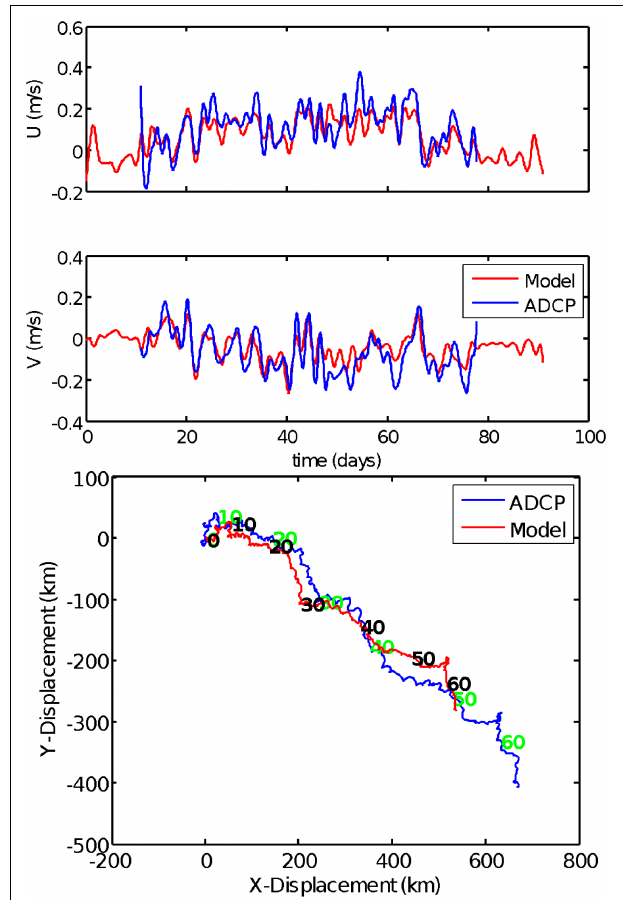
FIGURE 5 | Top panel: Comparison between U and V observed using ship-based ADCP (blue) and predicted using the GIOPS prediction system (red) Both data sets were filtered to remove high frequency in this plot. Bottom panel: Progressive vector plot of displacements for ADCP (blue with green labels), and model (red with black labels) over the 60 days of the data set. Number labels indicate the number of days of